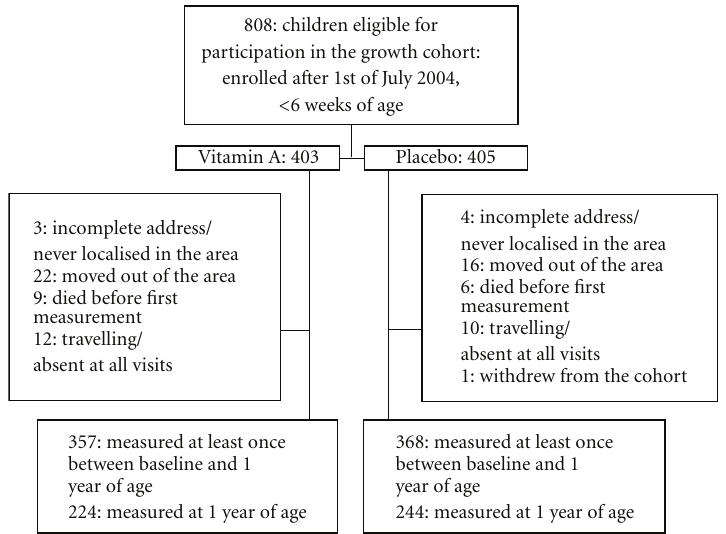
Figure 2: Flow of children through the